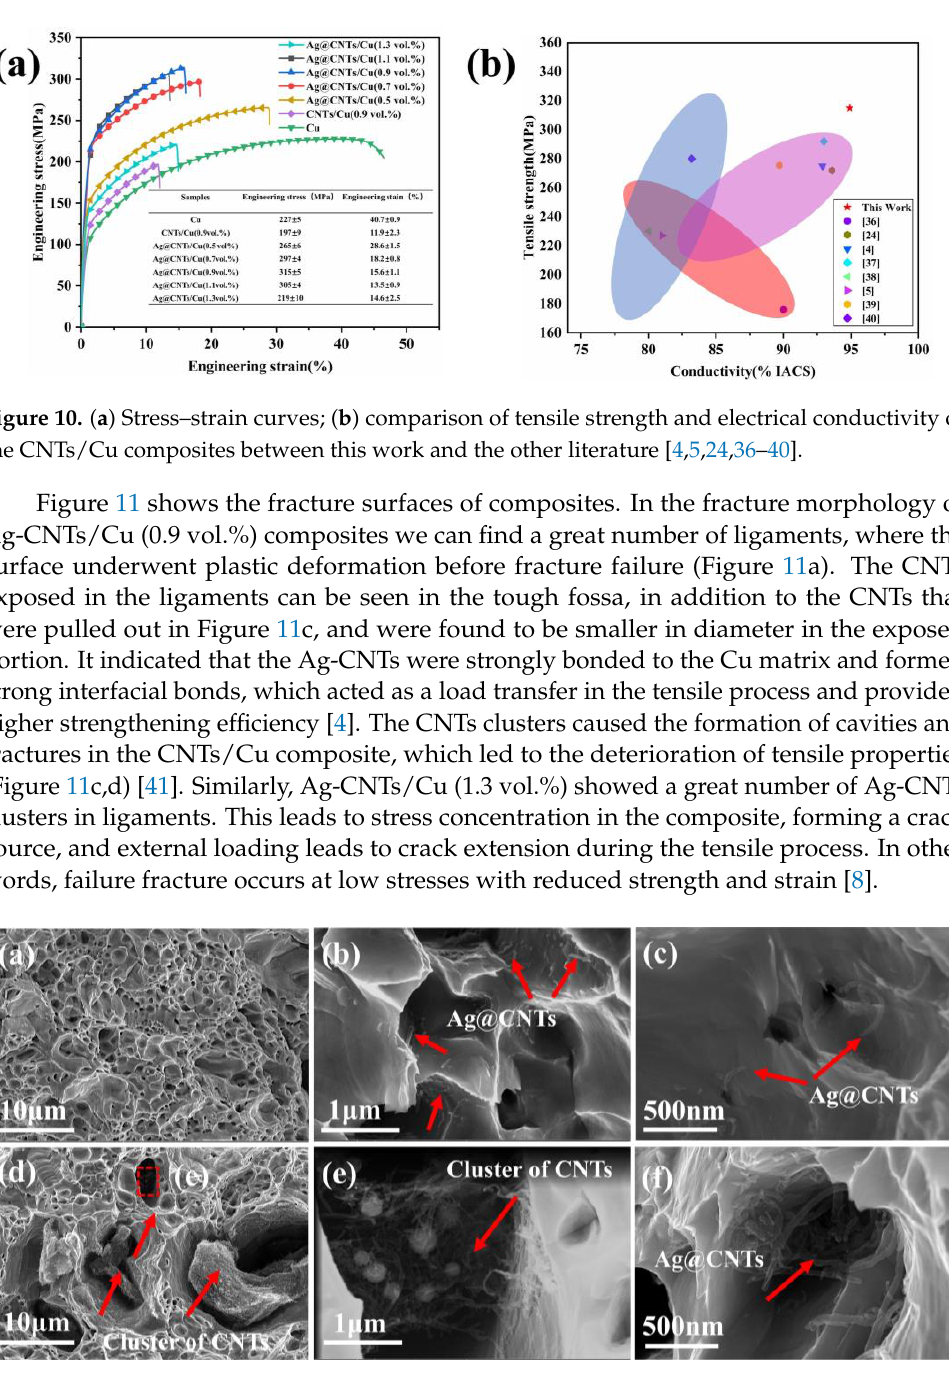
Figure 11. Fracture morphology of the composites: ( a – c ) 0.9 vol.% Ag-CNTs/Cu; ( d , e ) CNTs/Cu; ( f ) 1.3 vol.% Ag-CNTs/Cu morphology of the composites.